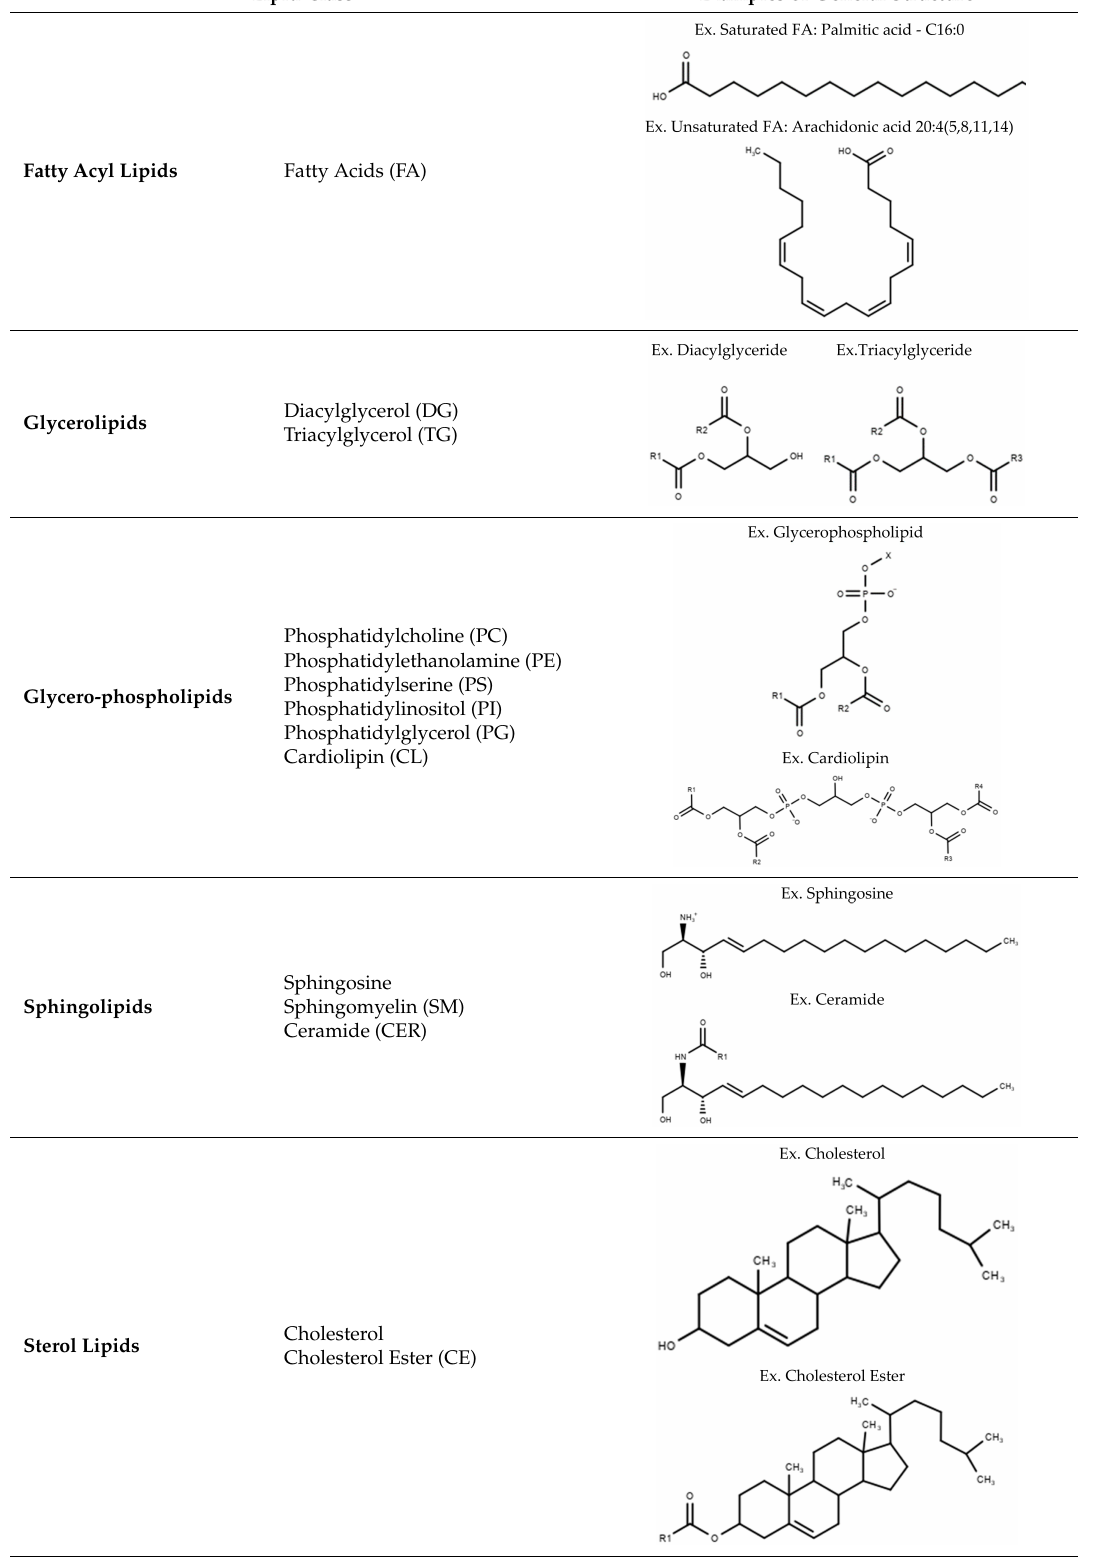
Table is limited to lipids discussed in the review. Structures are examples or general structures. R1, R2, R3, and R4 indicate unspecified fatty acid groups. X specifies phosphatidyl head group. Structures made with MarvinSketch Version 20.11